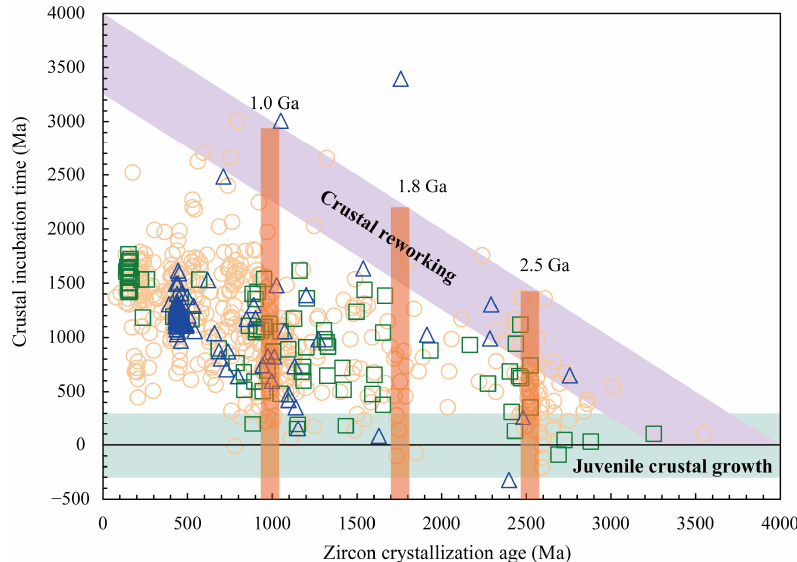
Figure 11. The plot of crustal incubation time versus crystallization ages of the detrital and inherited zircons from the (meta)sedimentary rocks in the Cathaysia Block. Crustal incubation time is defined by the difference between the zircon Hf model age and U–Pb crystallization age [83,84]. The data of the detrital zircons in the West Cathaysia Block are from [4,29,81,82], respectively. Green square, blue triangle and buff circle in this figure represent the inherited zircons from the Dengfuxian Jurassic granites, Tanghu Ordovician granites, and meta ‐ sediments of the West Cathaysia Block, re ‐ spectively.